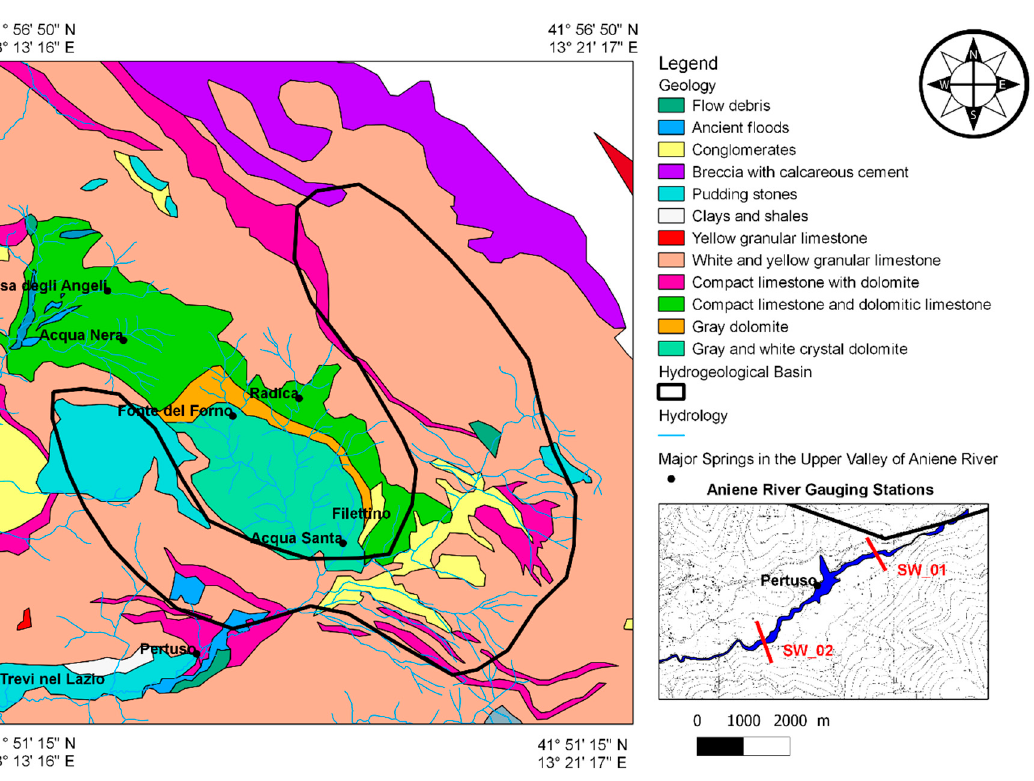
Figure 1. Simplified geological map of the Pertuso Spring hydrogeological basin and location of the Aniene River gauging sections.